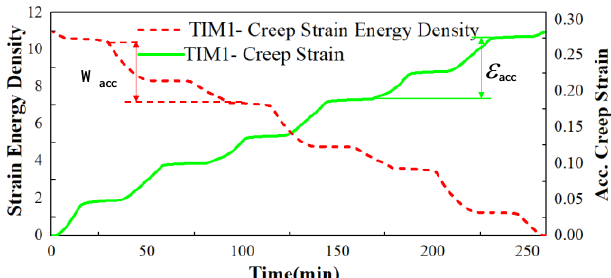
Figure 13: Accumulated creep strain and creep dissipation energy density distribution in solder join per cycle